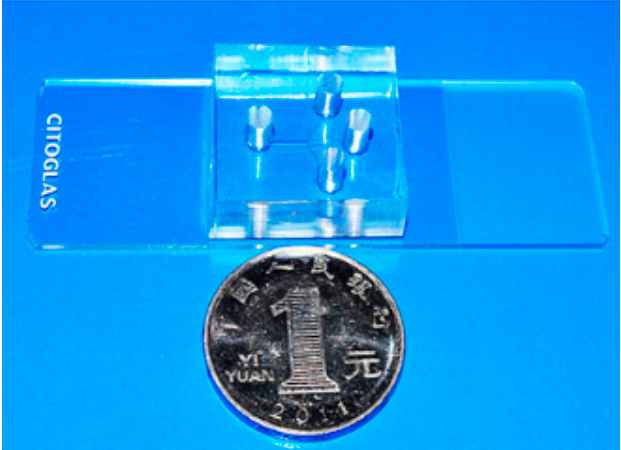
Figure 2. Photograph of the tiny microfluidic device.